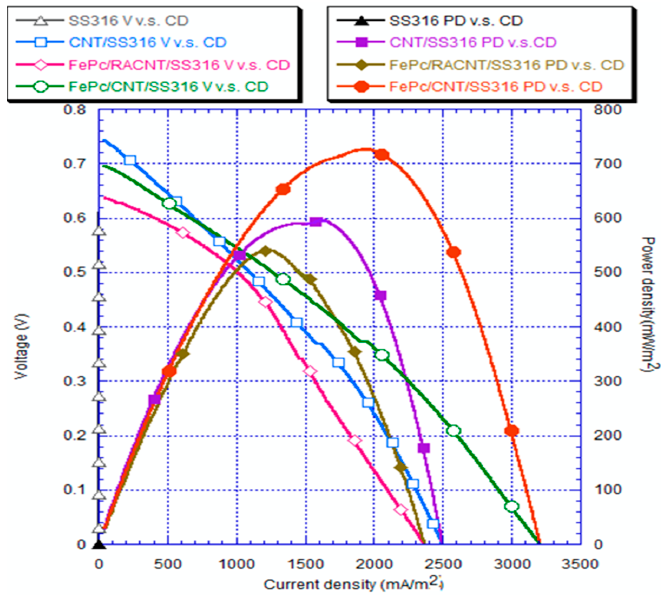
Figure 11. Plot showing comparison of electrical properties of voltage, current, and power on the fifth day after initiation of the bio-electro-Fenton system. day after initiation of the bio-electro-Fenton